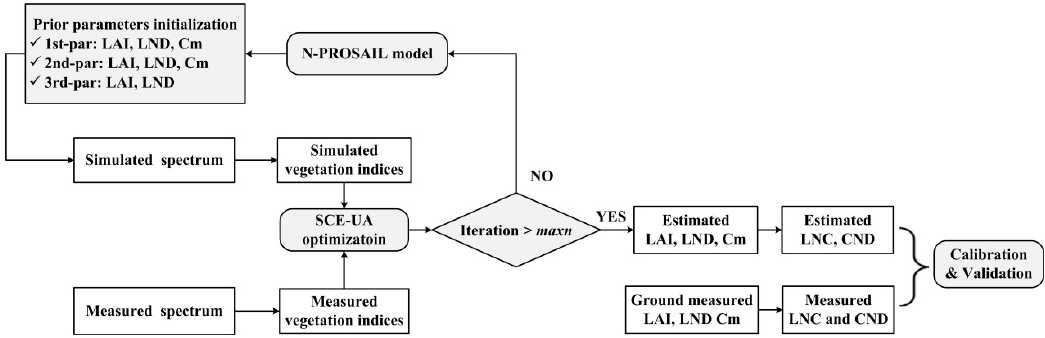
Figure 2. Flowchart of estimating leaf N concentration (LNC) and canopy N density (CND) with the N-PROSAIL model and the Shuffled Complex Evolution method developed at the University of Arizona (SCE-UA)